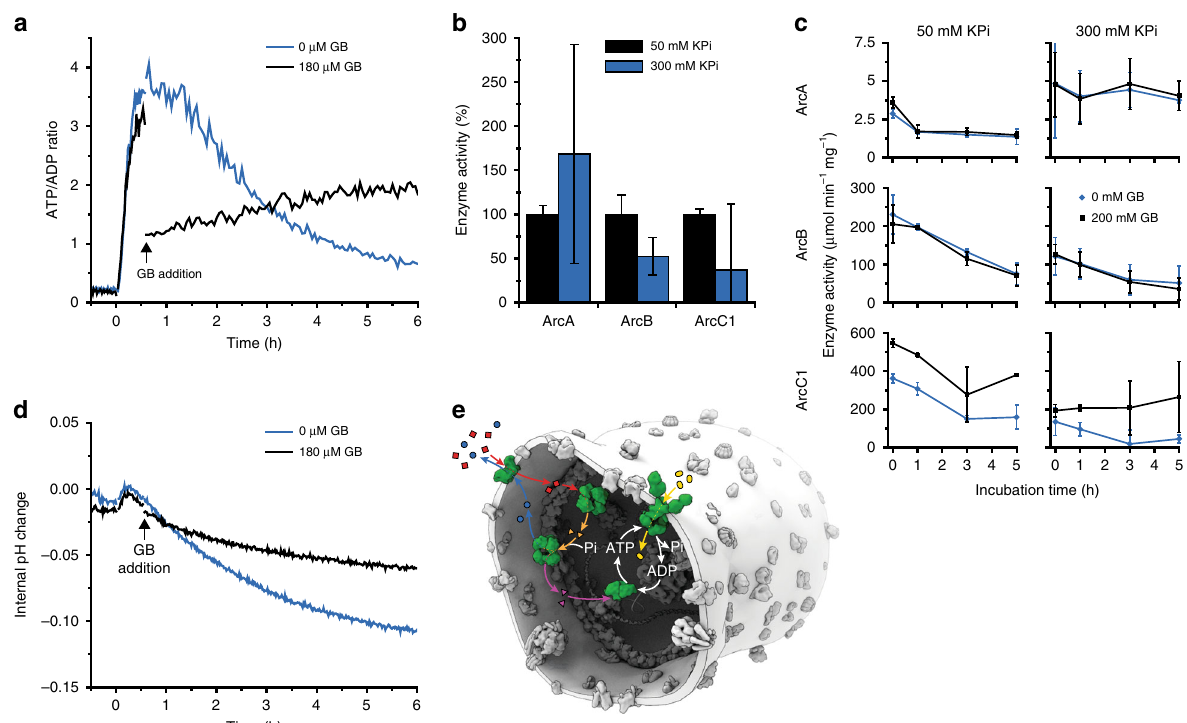
Fig. 6 Physicochemical homeostasis of arginine-metabolizing vesicles. The internal composition of the vesicles at the start of the experiment is given in Fig. 2a (enzymes) and Table 2 (ions, metabolites) and the preparation of vesicles is given in protocol A1, unless speci fi ed otherwise. a Effect of glycine betaine (GB) on the ATP/ADP ratio measured by PercevalHR (protocol B3) inside arginine-metabolizing vesicles exposed to an osmotic upshift (addition of 250 mM KCl externally) in the presence (black trace) and absence (blue trace) of 180 µ M glycine betaine, added at t = 0.5 h. Five millimolar arginine was added at t = 0 ( n = 3). b Activity of ArcA (left), ArcB (middle), and ArcC1 (right) in 50 mM KPi, pH 7.0 (black bar), and 300 mM KPi, pH 7.0 (blue bar) as determined from the production of citrulline (ArcA, ArcB) or ATP (ArcC1). The activities were normalized to those in 50 mM KPi, pH 7.0, the absolute activities are given in Supplementary Table 3; error bars indicate standard deviation ( n = 2). c Stability of ArcA (top), ArcB (middle), and ArcC1 (bottom) in 50 mM KPi, pH 7.0 (left), and 300 mM KPi, pH 7.0 (right) at 30 °C, in the presence (black squares) and absence (blue circles) of 200 mM glycine betaine ( n = 2). d Effect of glycine betaine on the internal pH measured by pyranine (protocol B4) inside arginine-metabolizing vesicles exposed to an osmotic upshift (250 mM KCl) in the presence (black trace) and absence (blue trace) of 180 µ M glycine betaine, added at t = 0.5 h. Five millimolar arginine was added at t = 0 ( n = 3). e Schematic representation of the synthetic metabolic network in the cell-like container with the intermediates: arginine (red squares), ornithine (blue circles), citrulline (orange triangles), carbamoyl-phosphate (pink triangles), and glycine betaine (yellow ovals). NH 3 and CO 2 are not shown. Source data of are provided as a Source Data fi